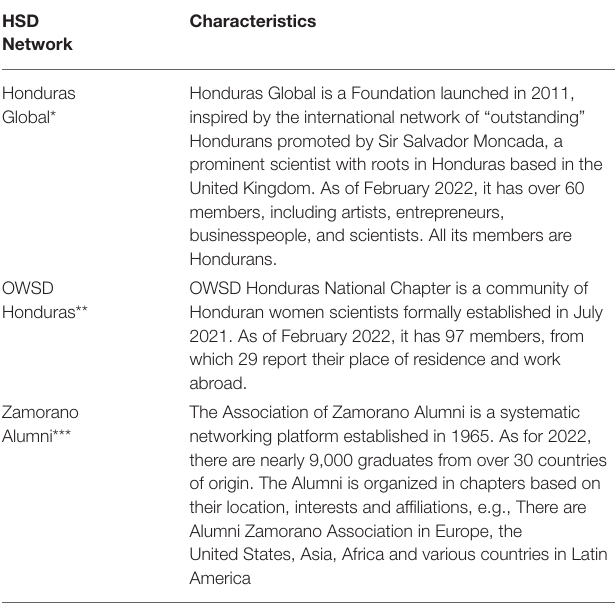
TABLE 2 | Honduras scientific diaspora selected networks. HSD